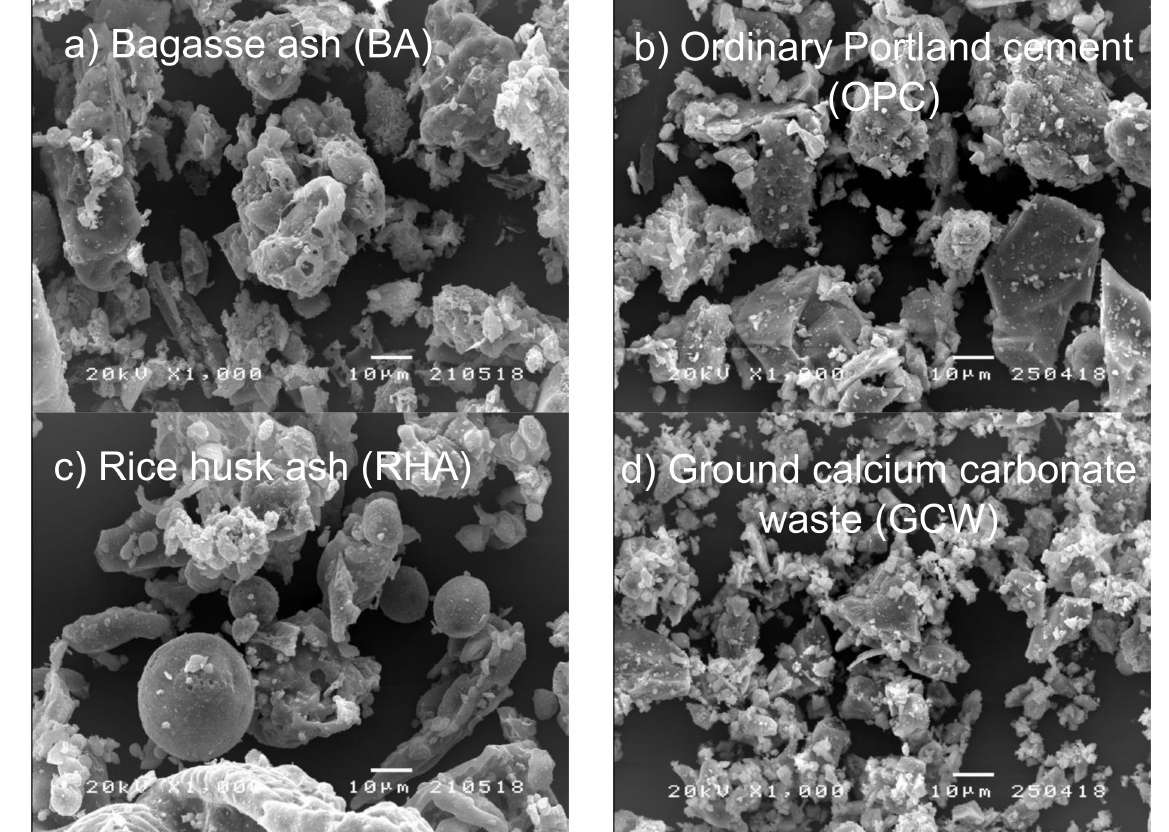
Figure 1. Scanning electron micrographs (1000 × ) of ( a ) BA, ( b ) OPC, ( c ) RHA, and ( d )